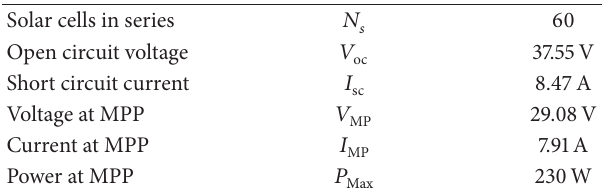
Table 1: SG-2300 electrical specifications at standard testing condi- tion.